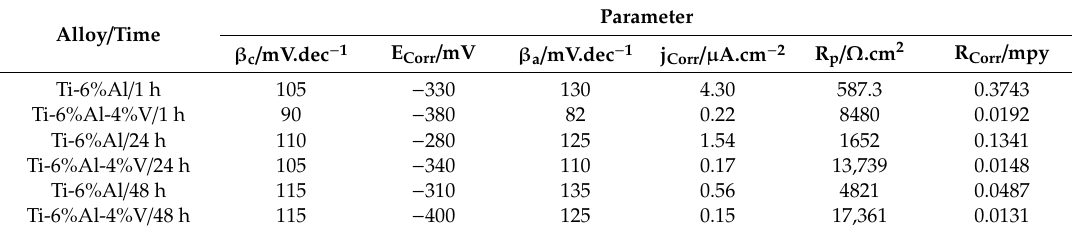
Figure 2. The polarization curves obtained for (1) Ti-6%Al and (2) Ti-6%Al-4%V alloys after the immersion in 3.5% NaCl solution for 1 h. Table 1. Polarization data for the Ti alloys after immersion in 3.5% NaCl solution for various periods of